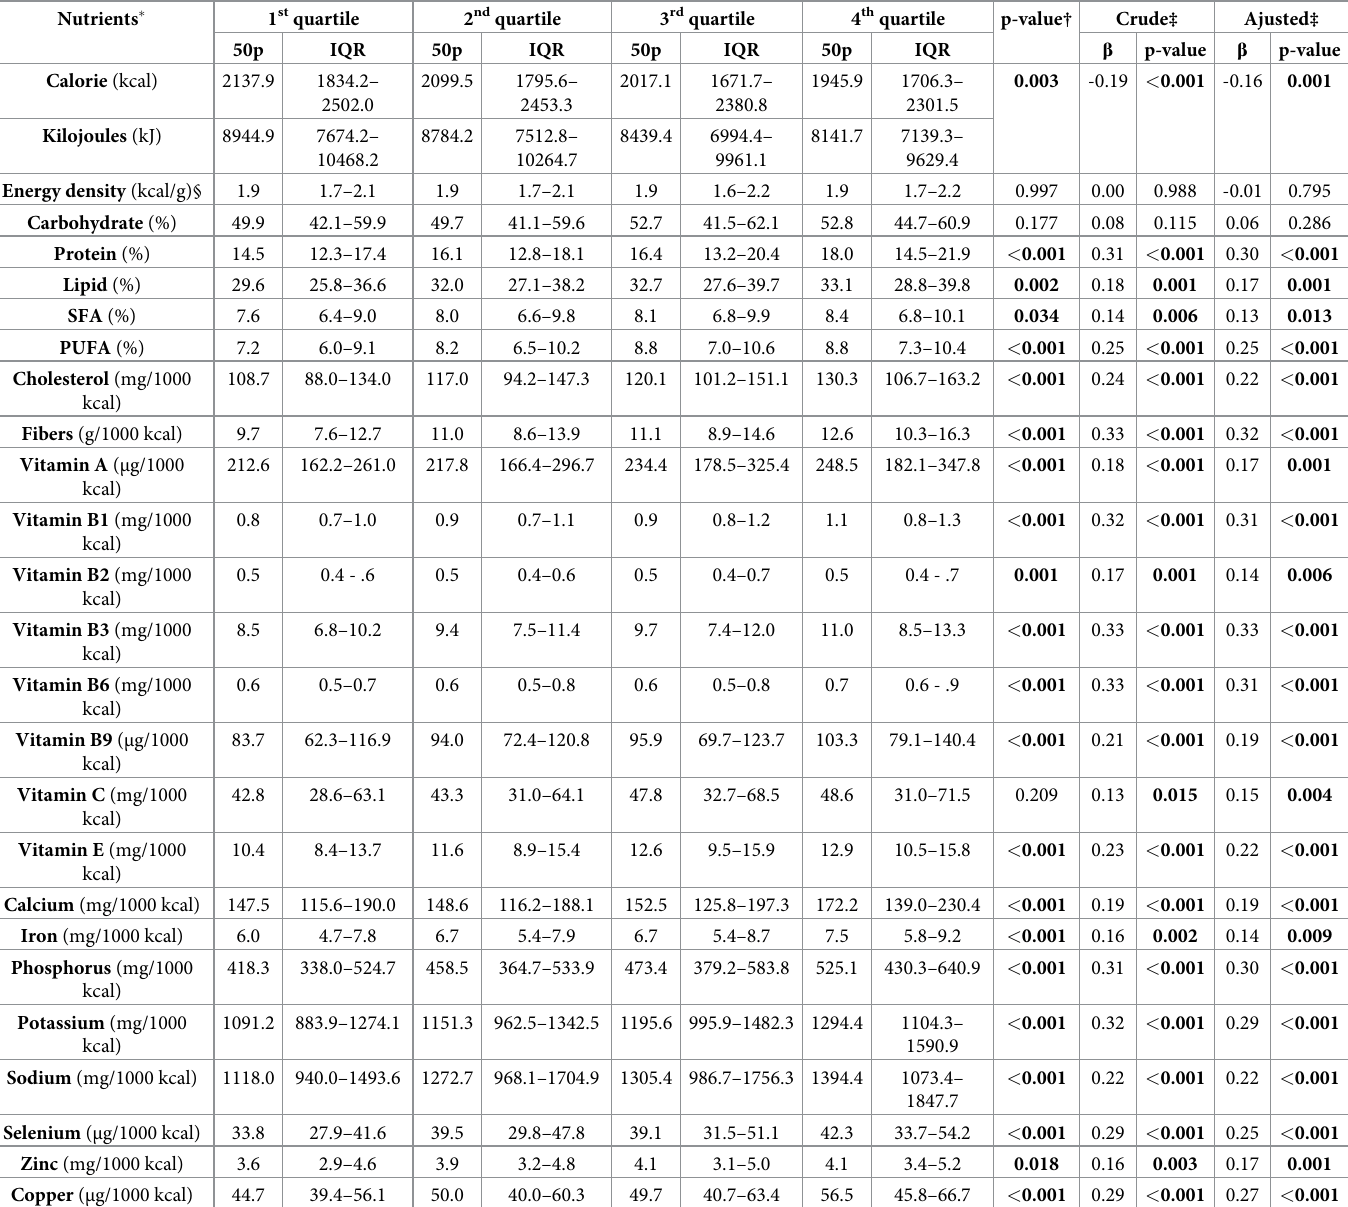
Table 4. Diet’s nutritional profile according to the caloric contribution of the consumption of minimally processed foods by Brazilian